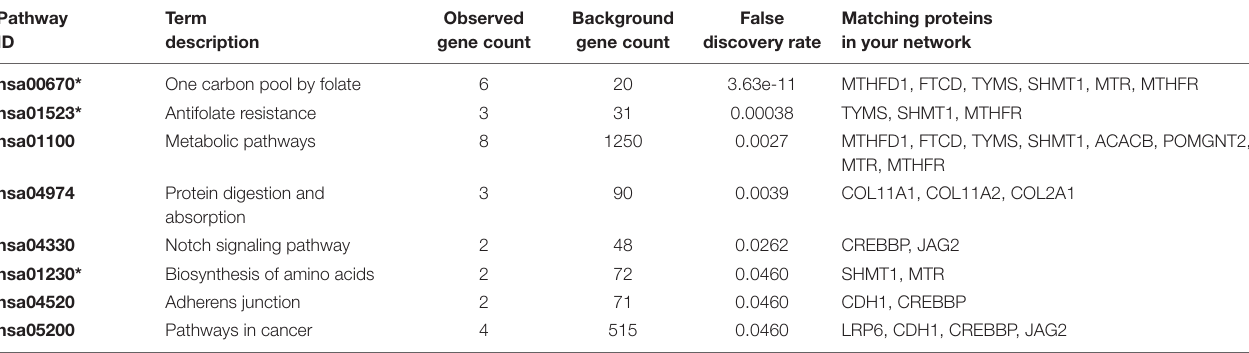
TABLE 2 | List of the overrepresented pathway formatted with the variant-containing-genes identified in patients with non-syndromic cleft palate only (NSCPO). Pathway Term ID description